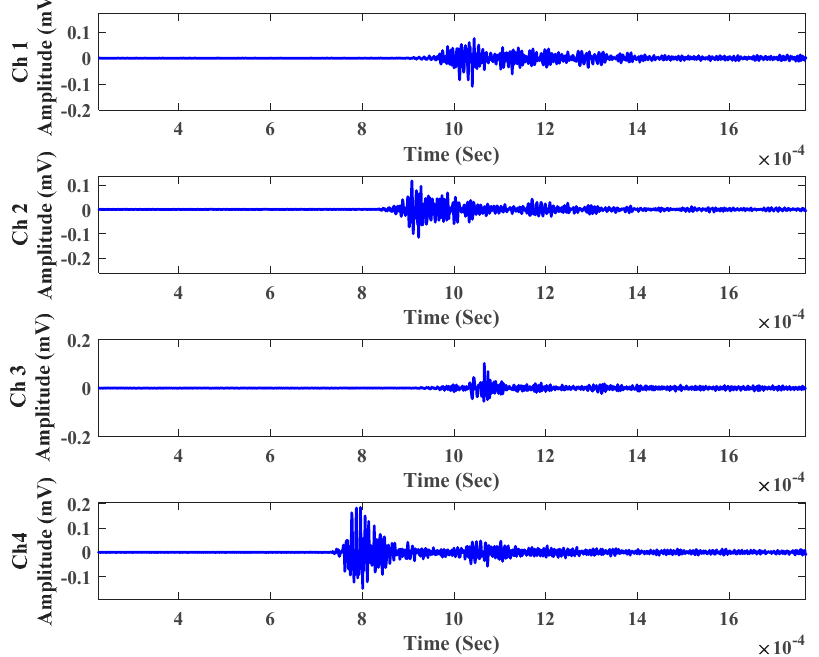
Figure 12. Acoustic emission signals obtained from the pencil lead break test (PLB)